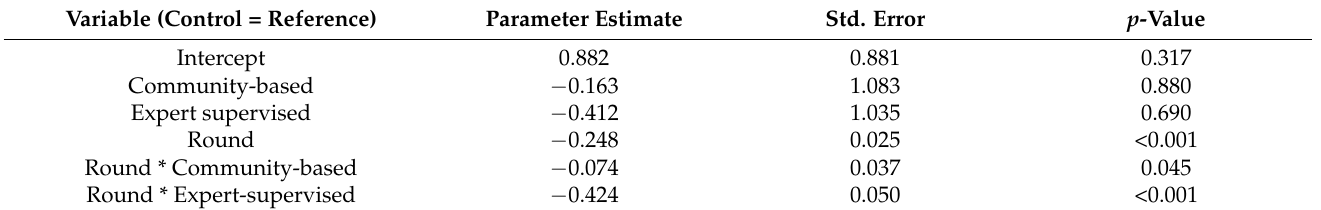
Table 2. Parameter estimates for the GLMM of occupancy rates of habitats with Anopheles larvae with sampling site included as random variable.